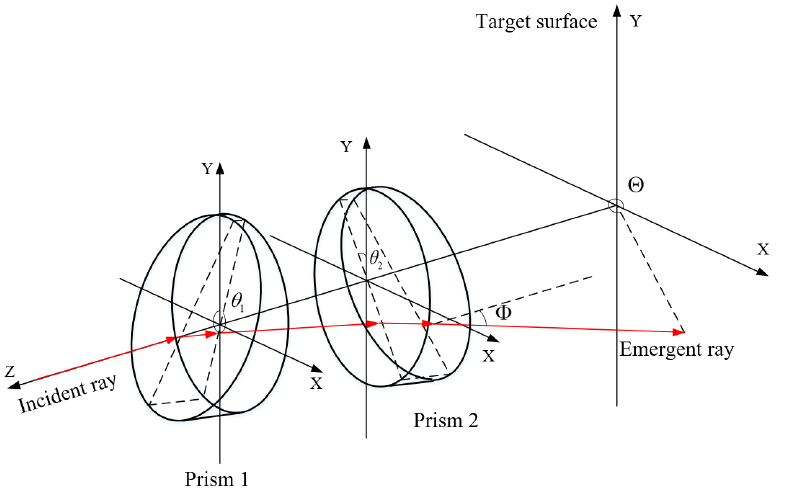
Figure 2. Schematic diagram illustrating the coordinate systems for Risley prisms. The incident ray, rotation axis of prisms, and Z ‐ axis are collinear.